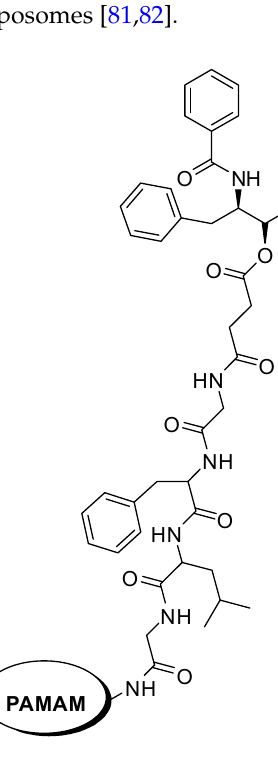
Figure 19. Janus peptide dendrimer selective for bone cancer therapy [80].